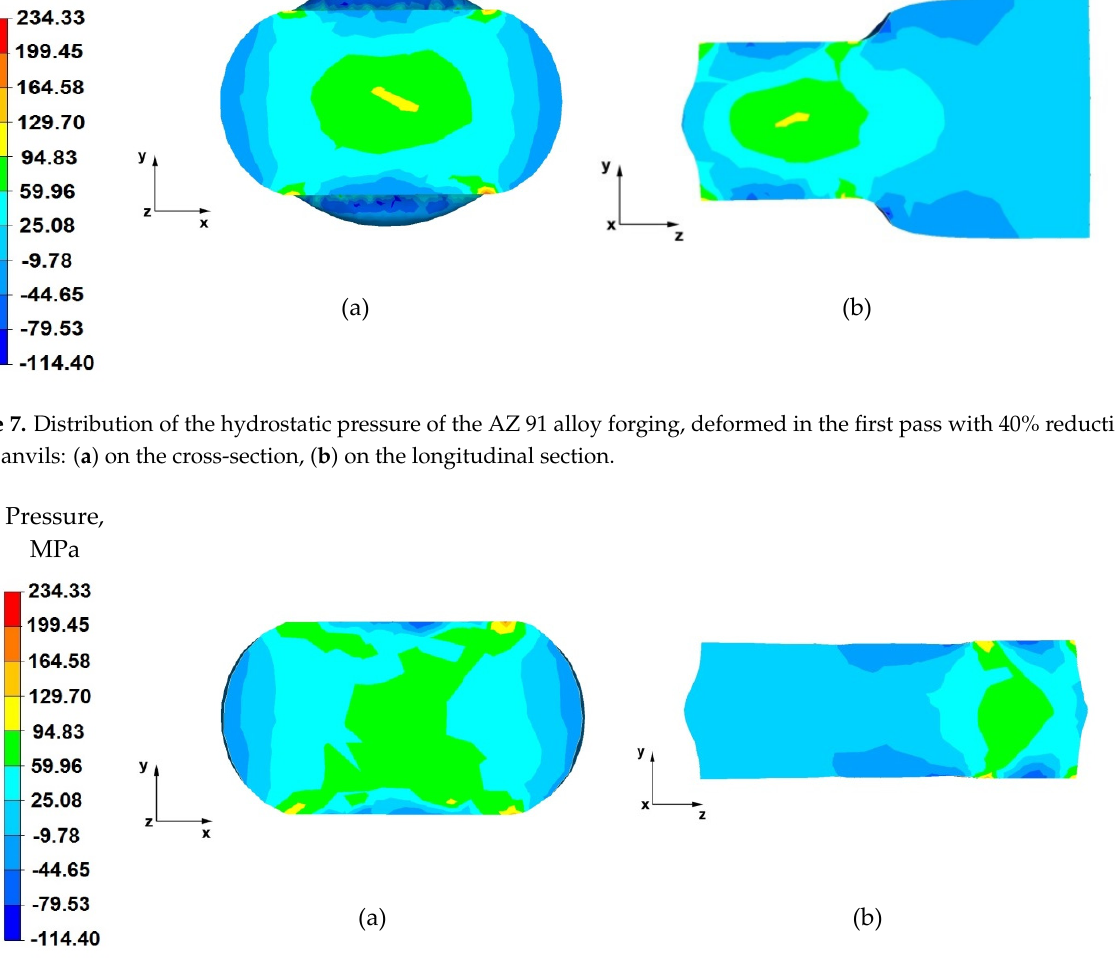
Figure 8. Distribution of the hydrostatic pressure of the AZ 91 alloy forging, deformed in the third pass with 40% reduction in flat anvils: ( a ) on the cross-section, ( b ) on the longitudinal section.